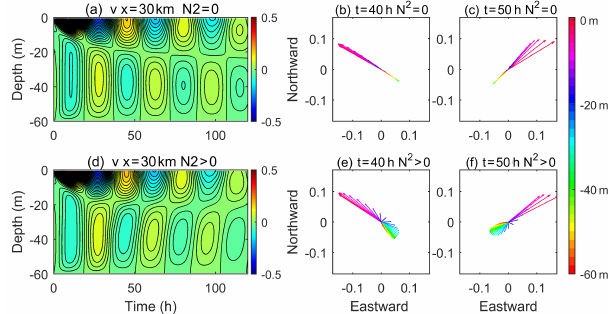
Figure 10. Distribution of near-inertial currents ( v , ms − 1 ) and cur- rent spirals for the cases without ( a , b , c ) and with ( d , e , f ) strat- ification at x = 30km. The near-inertial currents are obtained by applying a band-pass filter. The contour interval is 0.02ms − 1